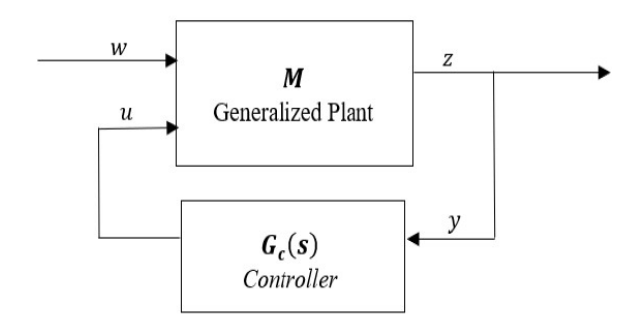
Figure 1. Feedback Control